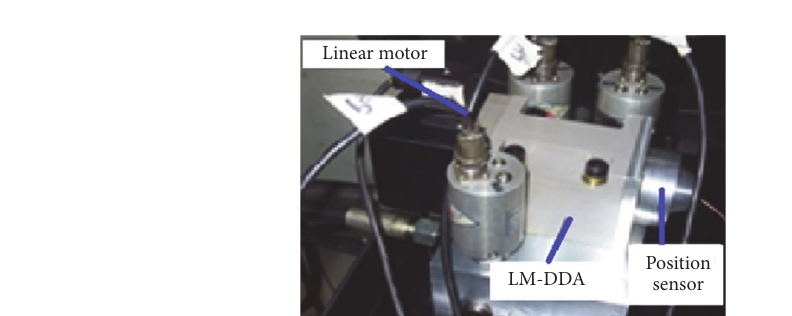
Figure 8: Schematic of system implementation.